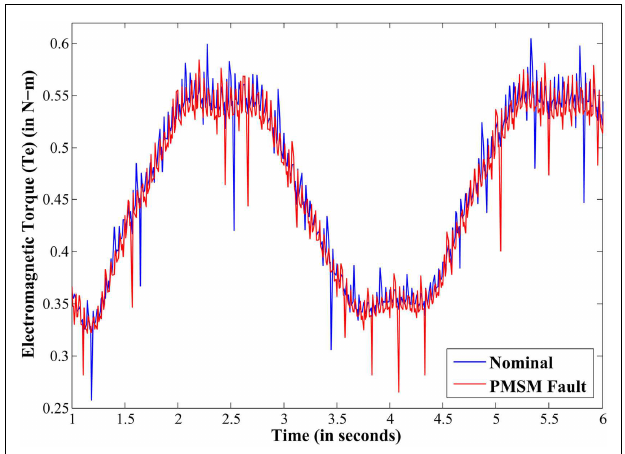
FIGURE 5 | Electromagnetic torque under nominal and PMSM fault conditions .